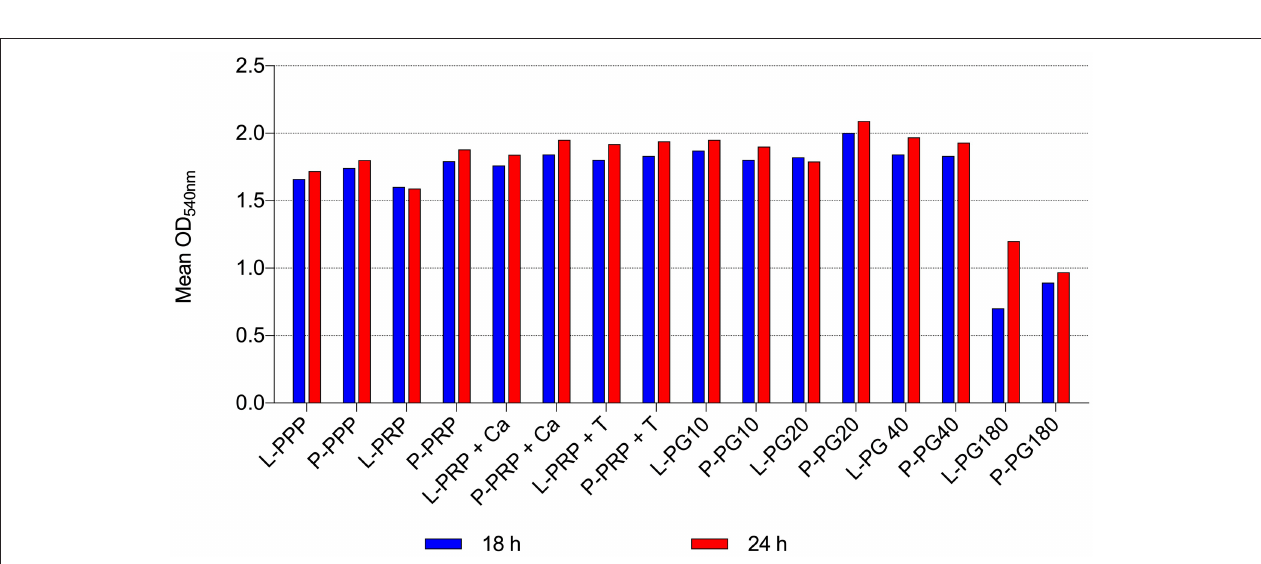
FIGURE 6 | Mean OD 540nm values of Gram-negative bacteria observed after 18 and 24h of incubation in the presence of different non-transfusional hemo-components. L-PPP, leukocyte platelet-poor plasma; P-PPP, pure platelet-poor plasma; L-PRP, leukocyte platelet-rich plasma; P-PRP, pure platelet-rich plasma; L-PRP + Ca, leukocyte platelet-rich plasma with calcium gluconate; P-PRP + Ca, pure platelet-rich plasma with calcium gluconate; L-PRP + T, leukocyte platelet-rich plasma with thrombin-rich solution; P-PRP + T, pure platelet-rich plasma with thrombin-rich solution; L-PG10, leukocyte platelet gel 10 µ l; P-PG10, pure platelet gel 10 µ l; L-PG20, leukocyte platelet gel 20 µ l; P-PG20, pure platelet gel 20 µ l; L-PG40, leukocyte platelet gel 40 µ l; P-PG40, pure platelet gel 40 µ l; L-PG180, leukocyte platelet gel 180 µ l; P-PG180, pure platelet gel 180 µ